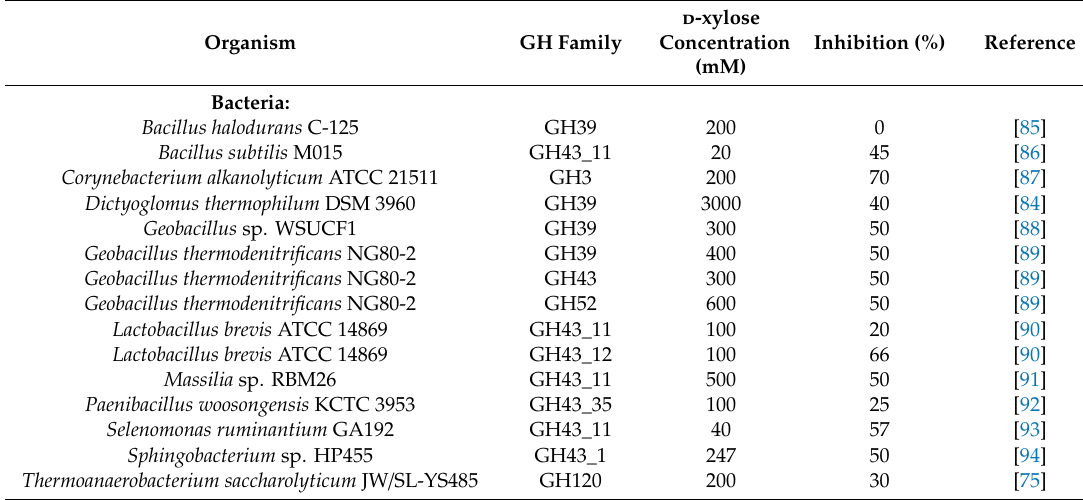
Table 2. Examples of microbial β -xylosidase inhibition by d